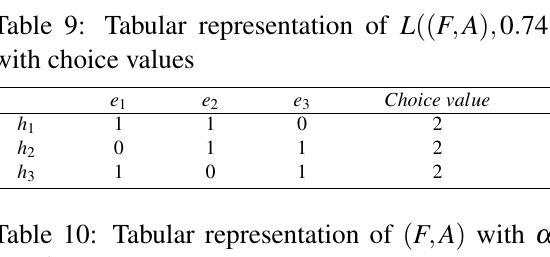
Table 10: Tabular representation of ( F , A ) with α i and β j values e 1